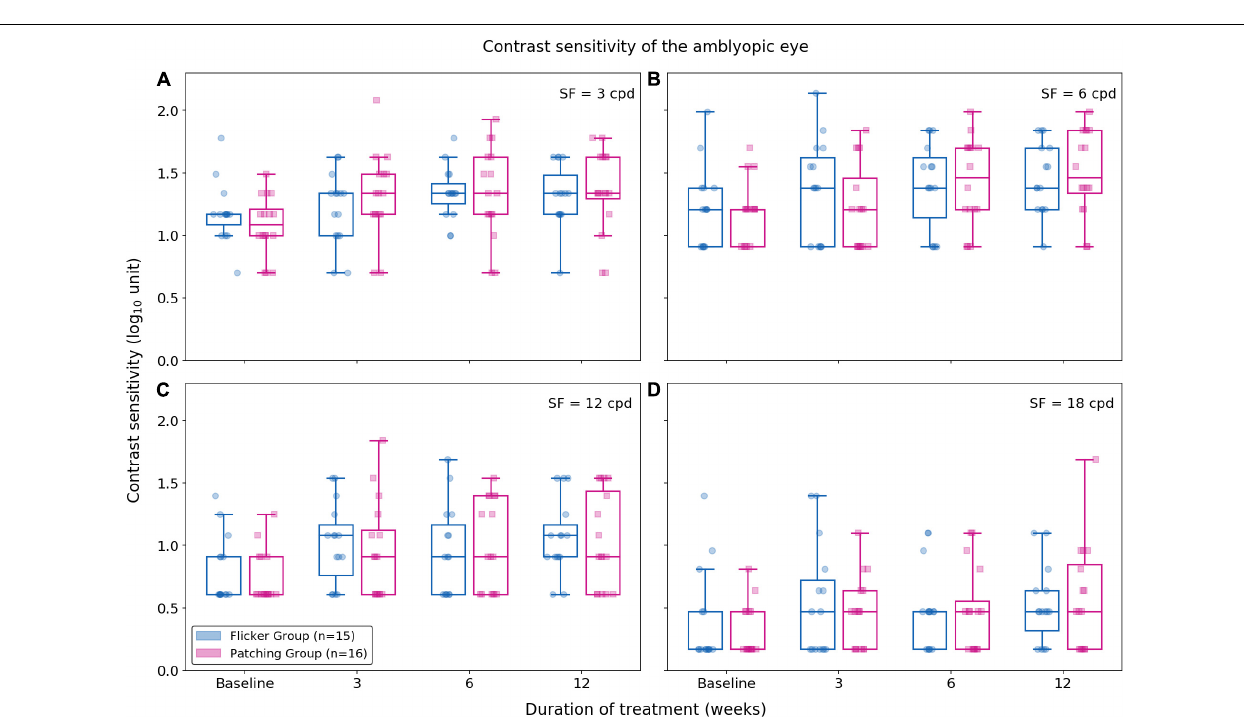
stereo threshold was 0.662 ± 1.93 log 10 arcsecs (mean ± SD) at 12 weeks. Both improvements were not significant ( p ’s > 0.05) relative to baseline (see Figure 4